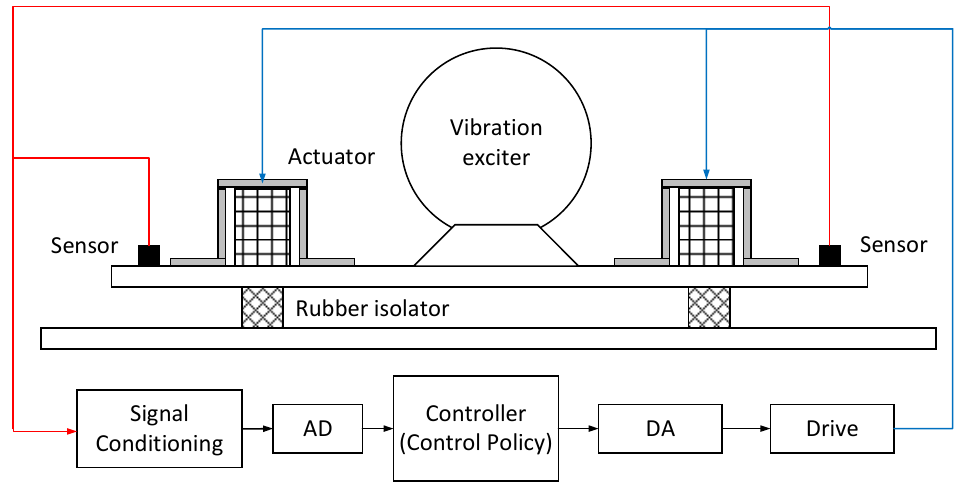
Figure 1. Schematic diagram of vibration-control system.